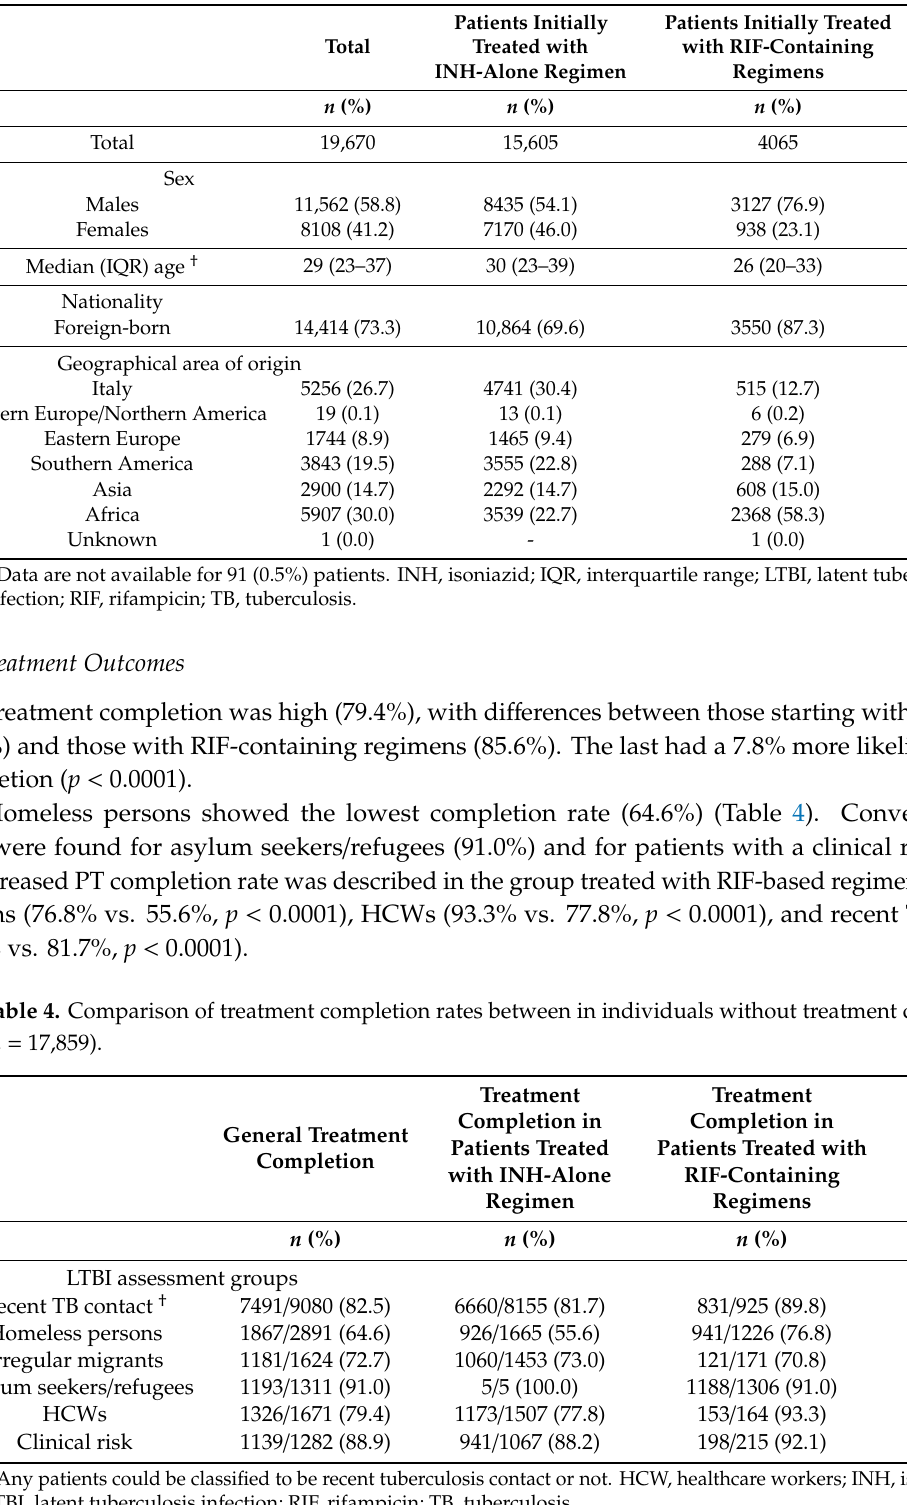
Table3. BaselinecharacteristicsofpatientswithLTBIinitiallytreatedwithINH-aloneandRIF-containing regimens ( n = 19,670).